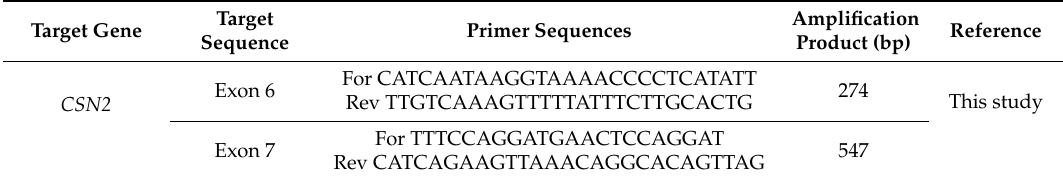
Table 2. Primer sequences (For, forward primer; Rev, reverse